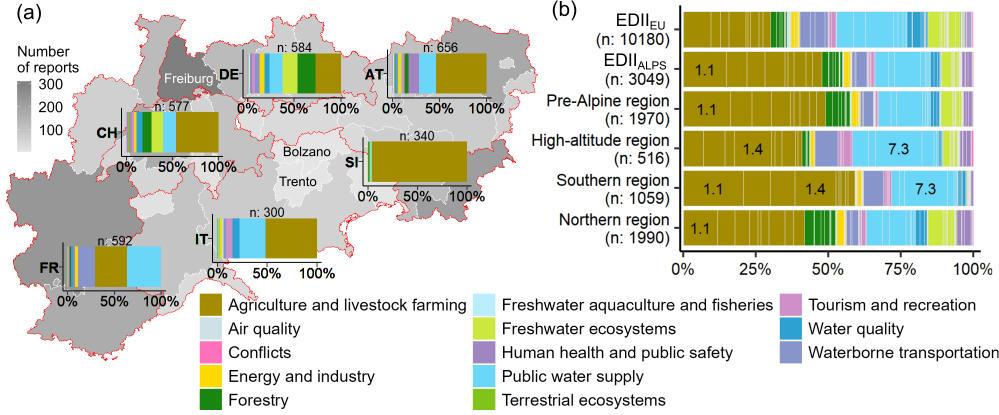
Figure 2. Reported impacts in 13 coloured categories by region ( n = total no. of reports per region). (a) Fraction of impact category per country. NUTS 2 regions with significant differences are labelled (see Table 1). (b) Fraction of impact categories covering several subtypes (faint lines) for the domains. Subtypes with a fraction ≥ 10% per region are labelled.